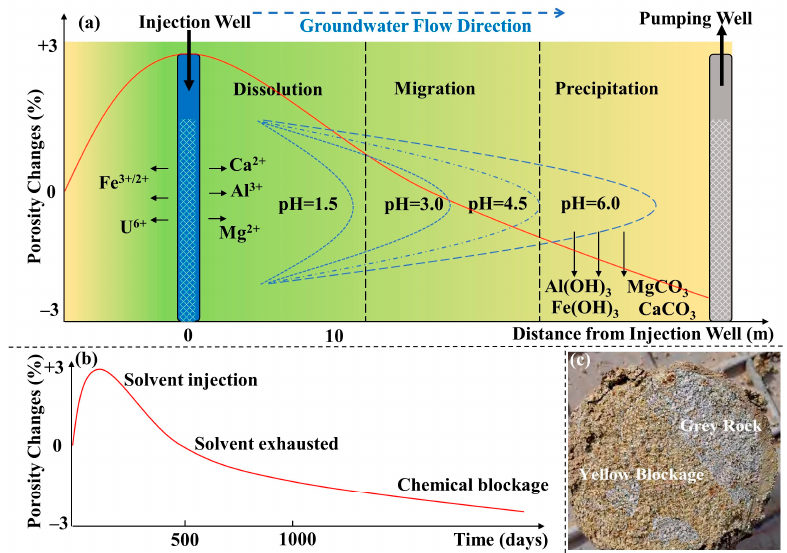
Figure 8. Chemical clogging during ISL. ( a ) Shows that chemical clogging occurs in space, while ( b ) shows that chemical clogging occurs over time; the red line shows the porosity changes; a positive value on the vertical axis indicates an increase, while a negative value indicates a decrease; ( c ) shows the yellow blockage in the gray rock, and the sample was collected in a decommissioned uranium mine in Northwest China.